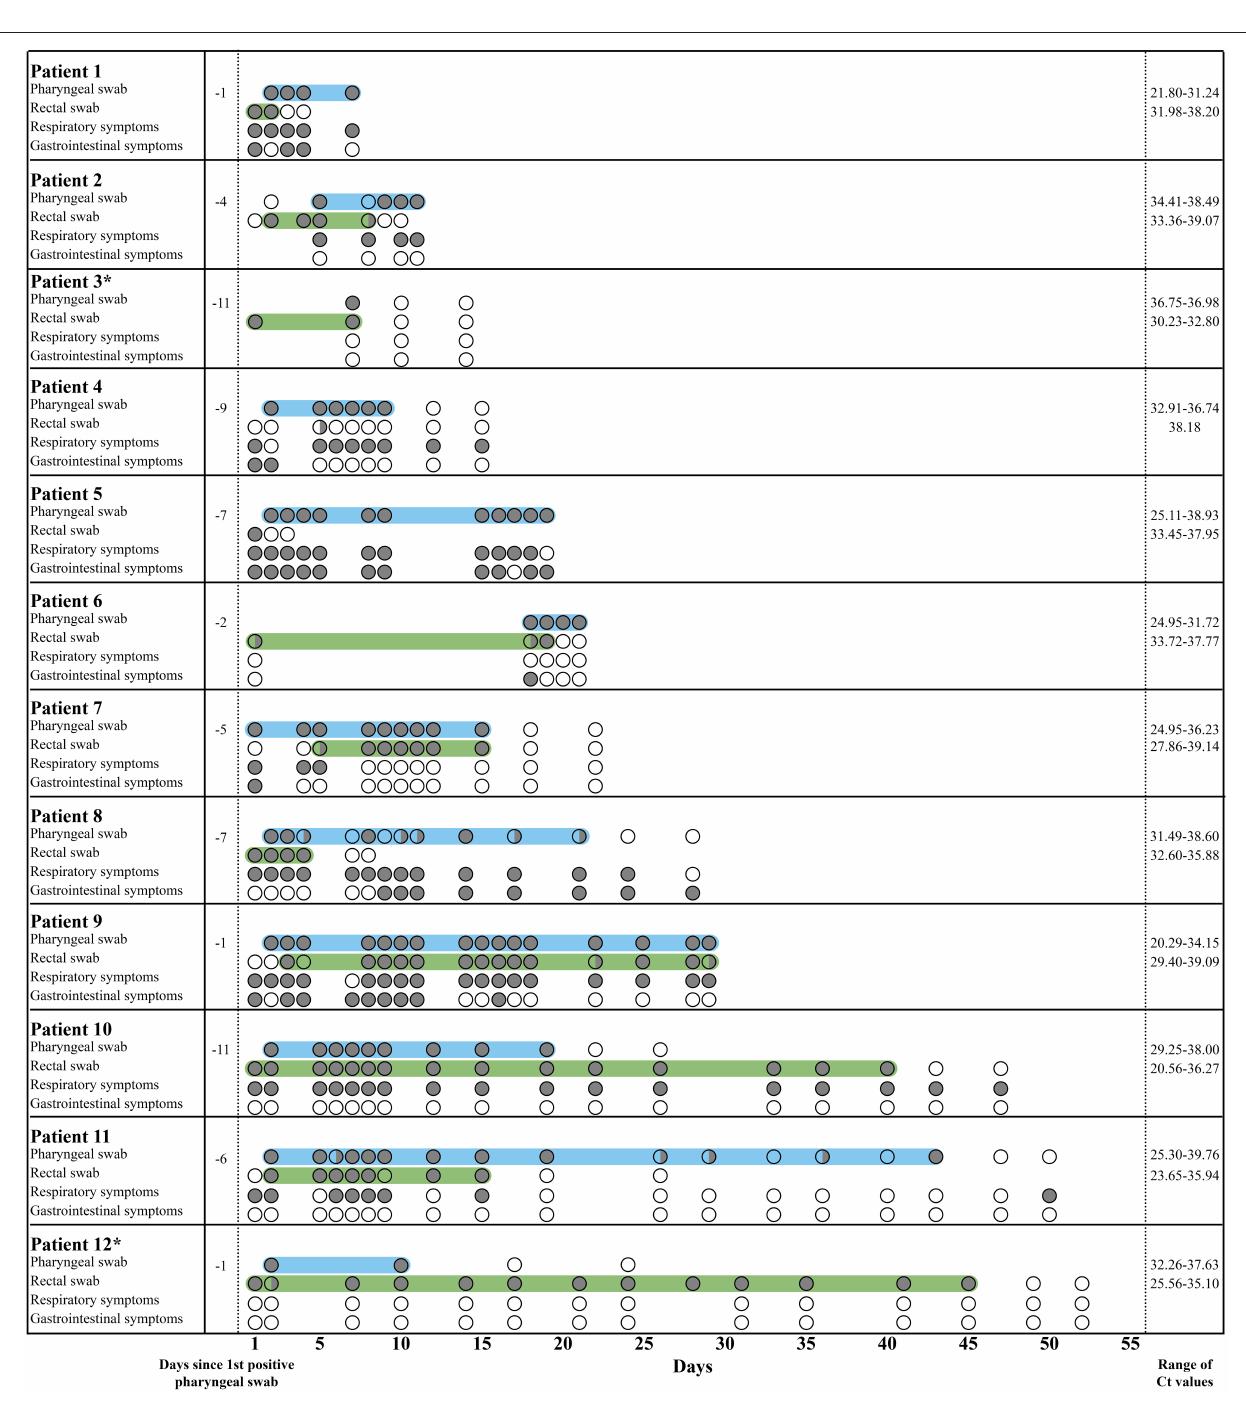
Frontiers in Medicine |